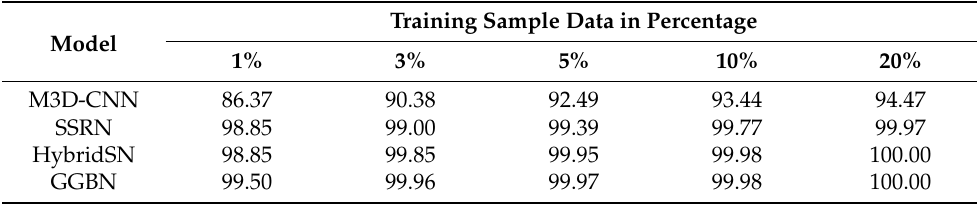
Table 7. Performance of the selected models on varied training sample data over SA